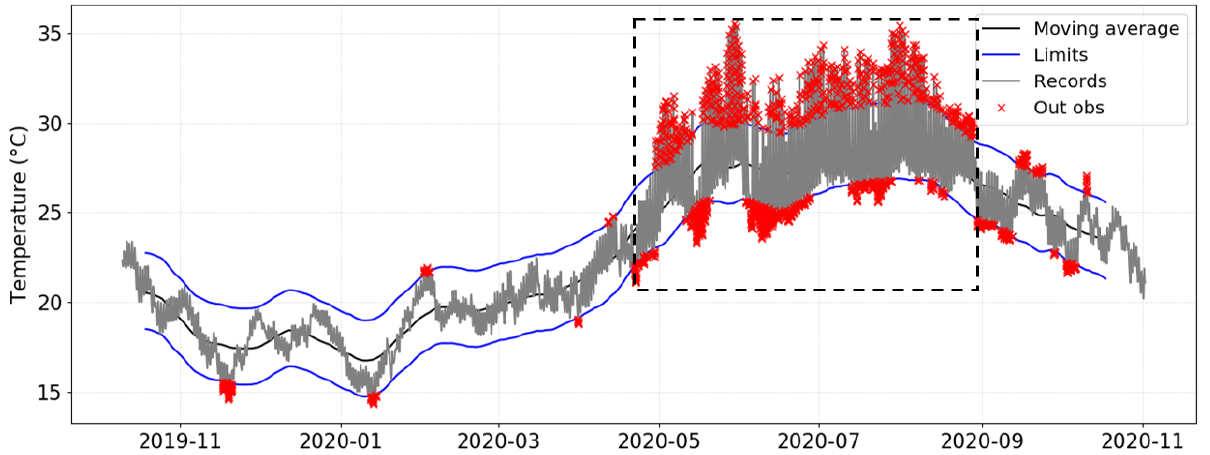
Figure 3. Evolution over time of temperatures recorded by data-logger B2. The seasonal trend is indicated as a black line. Security limits calculated according to EN 15757:2010 are depicted in blue. The box in dashed lines indicates the period with a higher frequency of short-term fluctuations, between April 20th and September 1st.